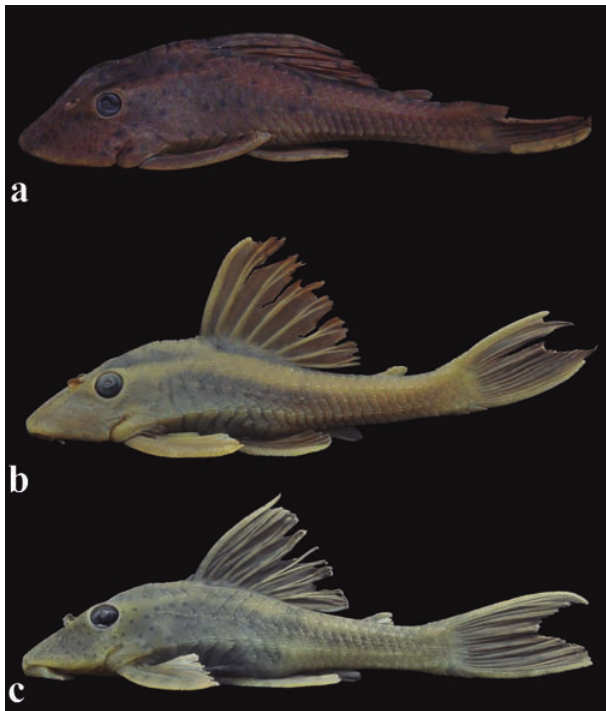
Fig. 4. Lateral view of juvenile in (a) Hypostomus cochliodon , NUP 11956, 92.8 mm SL, (b) Hypostomus basilisko , paratype, ZUFMS-PIS 3083, 64.2 mm SL and (c) Hypostomus khimaera , NUP 13494, 68.8 mm